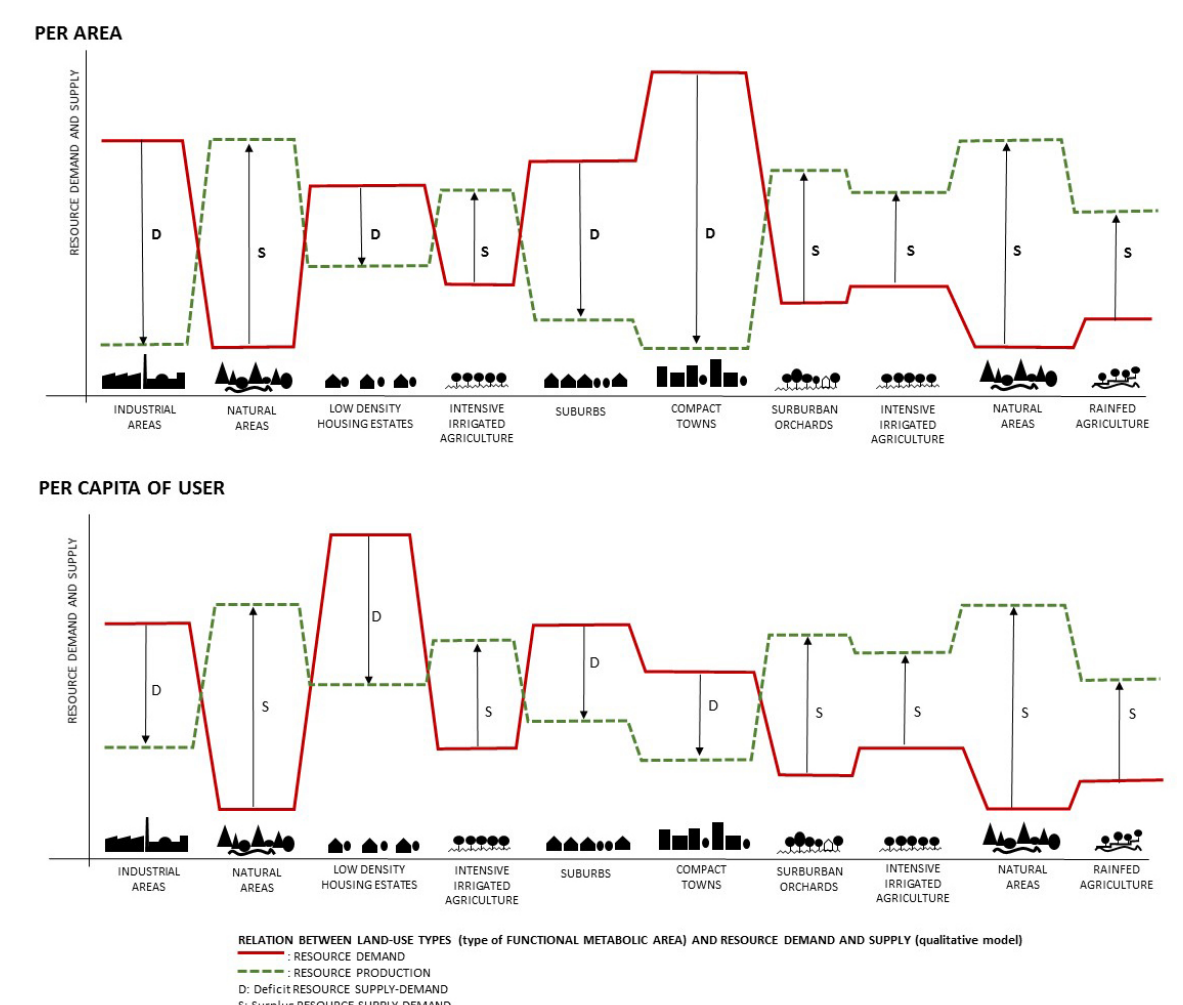
Figure 8. Conceptual diagram expressing resource production and resource demand for different types of FMAs in urban and non-urban areas of the Sierra Calderona per area (on top) or per capita